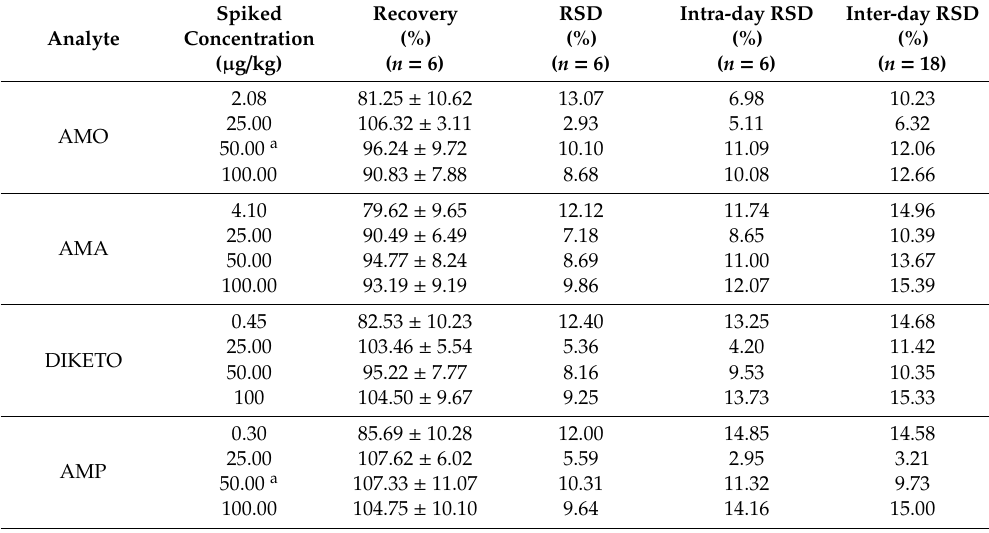
Table 5. Recoveries from and precision of the analysis of AMO, AMA, DIKETO, and AMP spiked in blank muscle tissue.